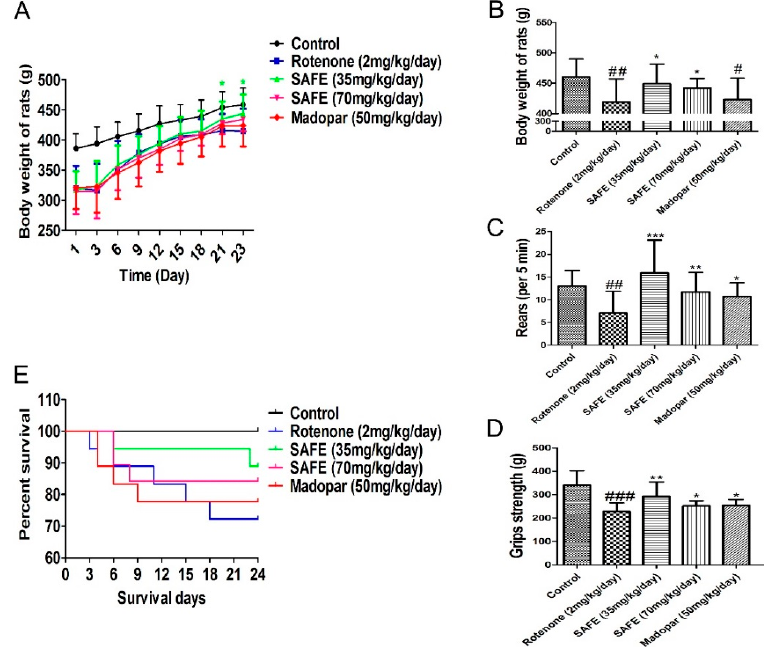
Figure 3. Changes in body weight and behavioral parameters during SAFE treatment. ( A ) Body weight change during the SAFE treatments from day 1 to day 23; ( B ) Body weight change during the SAFE treatments day 24; ( C ) Rearing behavior result after 24 days of SAFE treatments; ( D ) Grip strength result after 24 days of SAFE treatments; ( E ) Survival of during 24 days SAFE treatments. The parameters are presented as the mean ± SD, ( # compared to control, # p < 0.05, ## p < 0.01, ### p < 0.001; * compared to rotenone * p < 0.05, ** p < 0.01, *** p < 0.001) (control n = 10, other group n = 18).